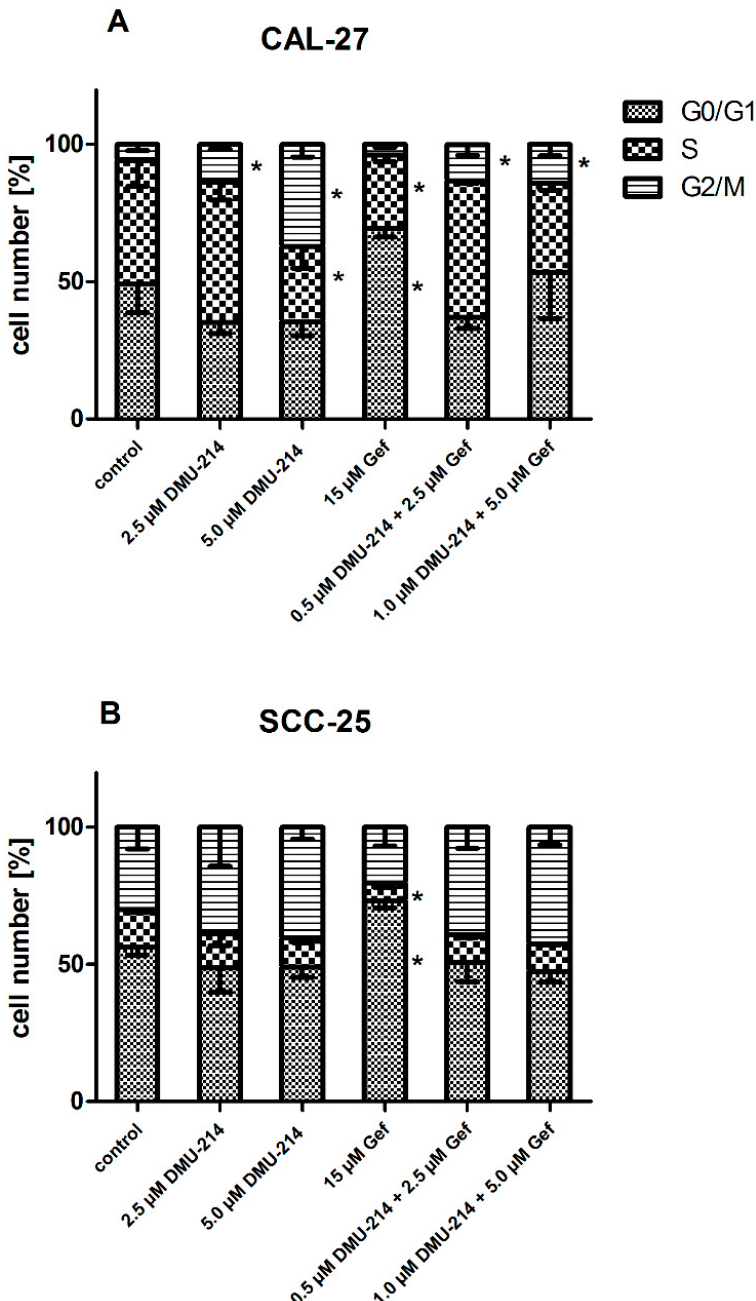
Figure 4. Effect of DMU-214, Gef, and the combination of DMU-214 and Gef on cell proliferation compared to the vehicle-treated control. Cell cycle phase distribution was analyzed by flow cytometry in CAL-27 ( A ) and SCC-25 ( B ) cell lines treated for 24 h with the vehicle, DMU-214 (2.5 µ M and 5.0 µ M), Gef (15 µ M), and the mixtures of both compounds: (i) 0.5 µ M DMU-214 and 2.5 µ M Gef, (ii) 1.0 µ M DMU-214 and 5.0 µ M Gef. Results of three independent replicates are presented as mean ± SD. * p < 0.05 indicates a significant difference from the control.